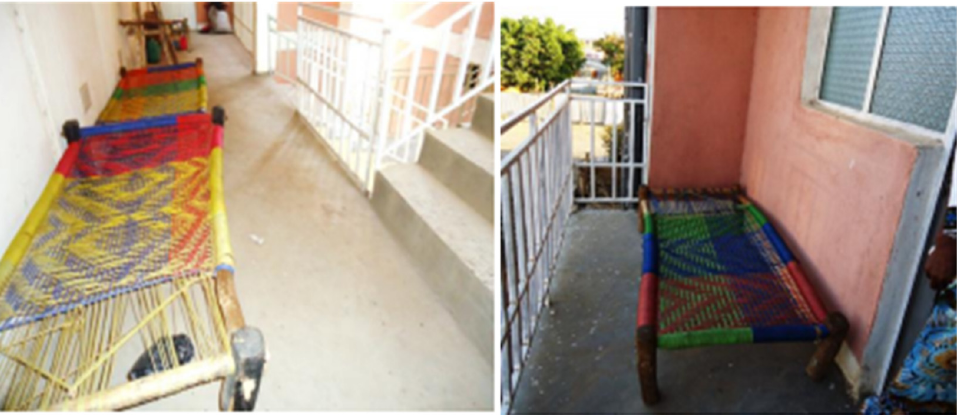
Figure 18. Bed positioned at corridor and balcony.